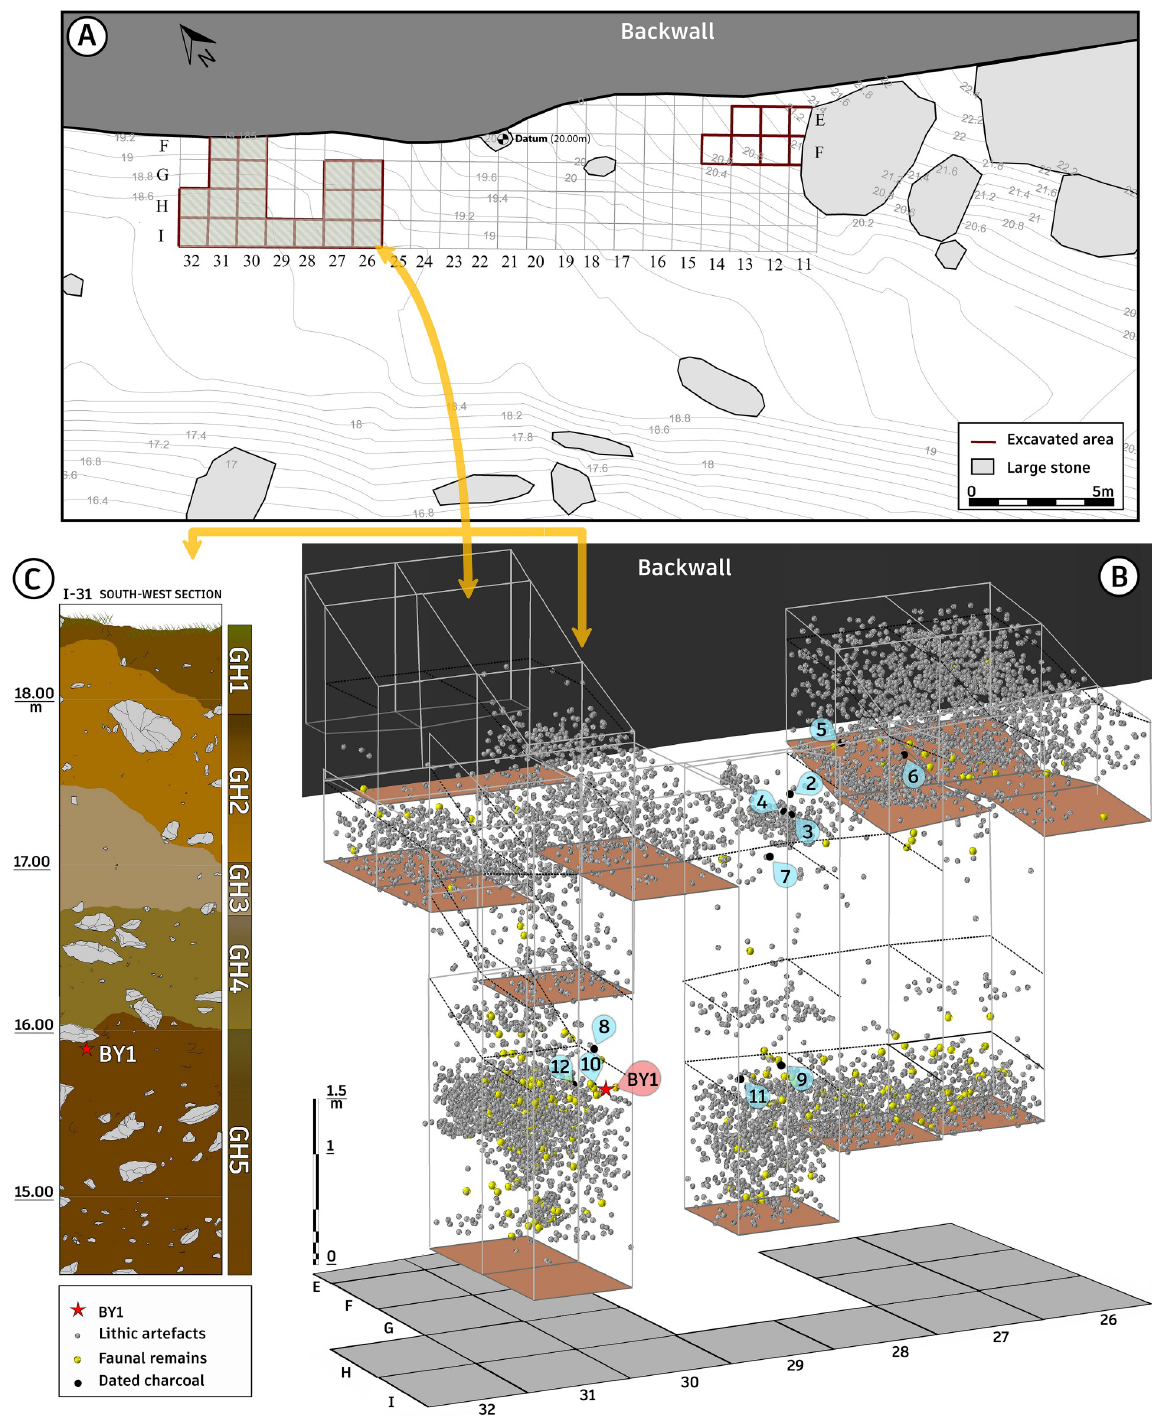
Fig 3. Bawa Yawan rockshelter. A. Topographic map and plan of the rockshelter showing the excavation area. B. 3D of the Western trench including position of BY1, dated charcoals, fauna and lithic artifacts. C. Profile shows the south-western wall of sq. I31, geological horizons and position of